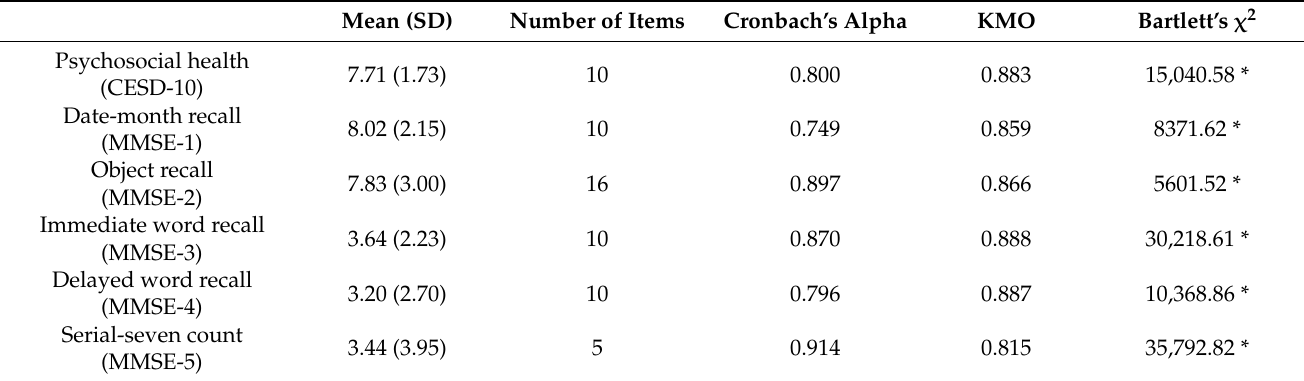
Table 2. Psychometric properties of psychosocial health and cognitive performance ( n =